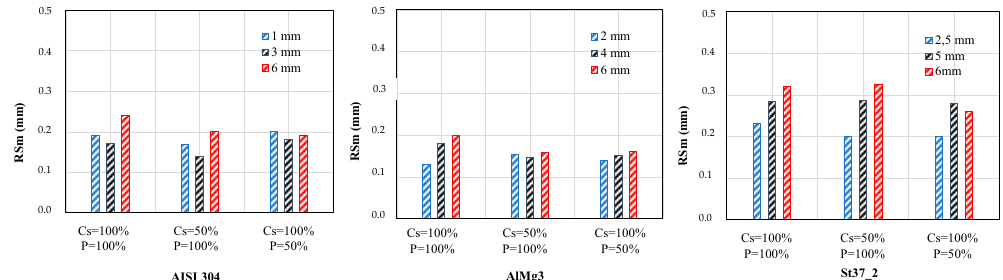
Figure 18. Arithmetic mean surface roughness.